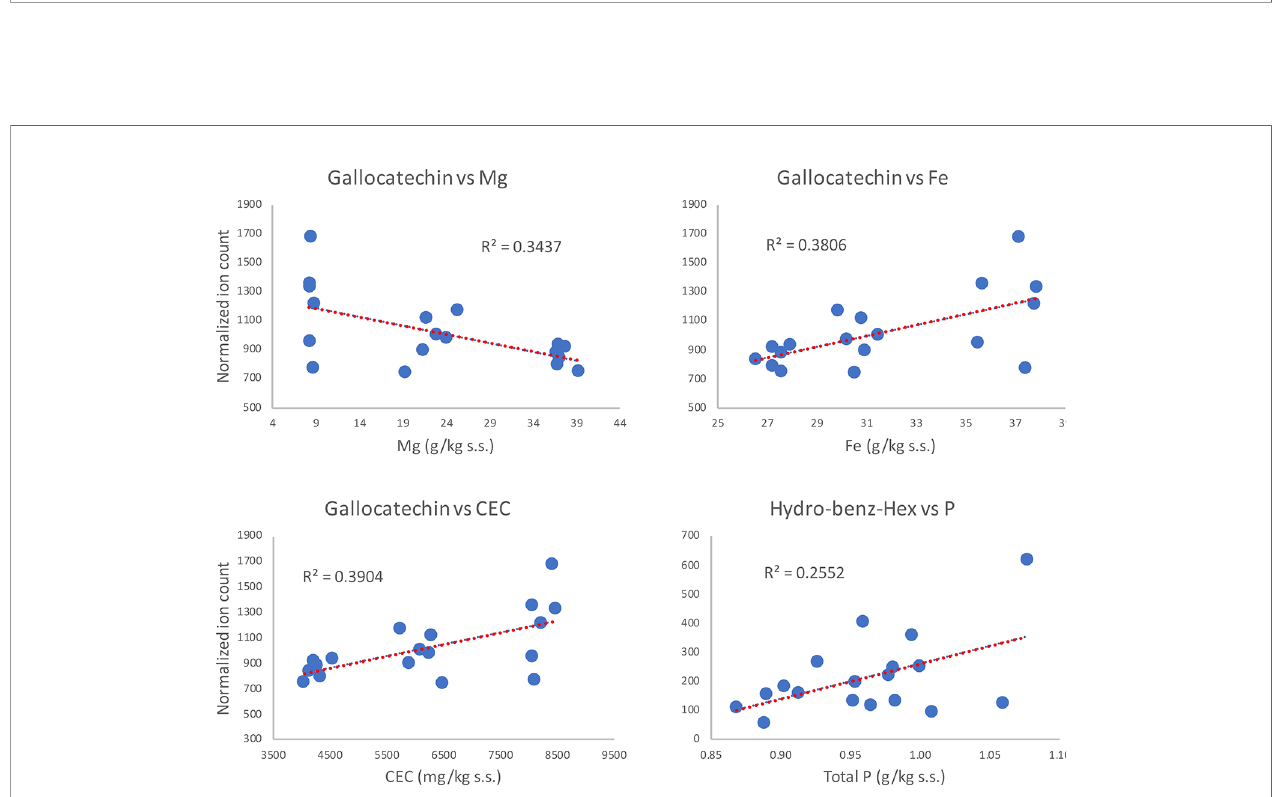
FIGURE 8 | Regression analysis of grape metabolites at harvest (ripening; R) signi fi cantly correlating (P > 0.05) with soil features, independently of the